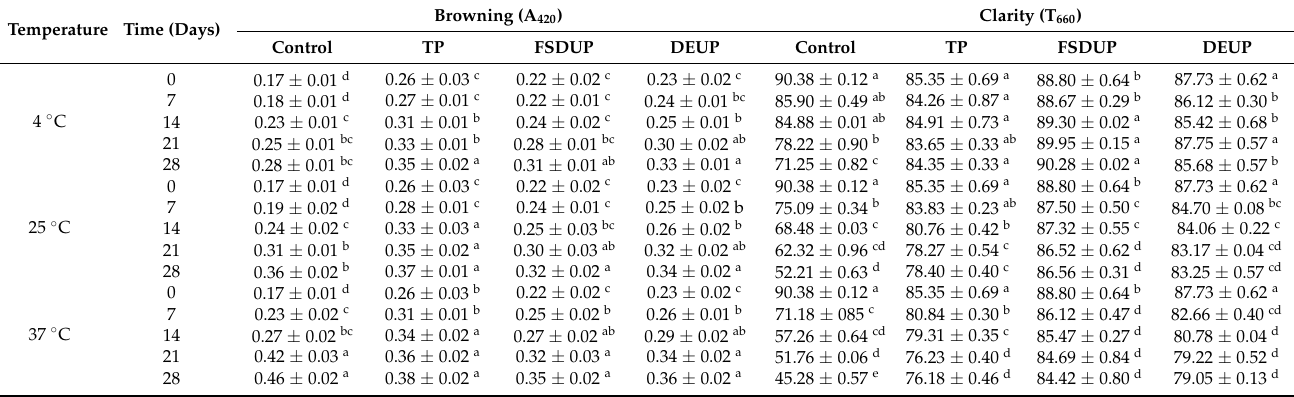
Table 4. Changes in browning and clarification of strawberry clear juice during storage after thermal pretreatment and multi-mode thermosonication.